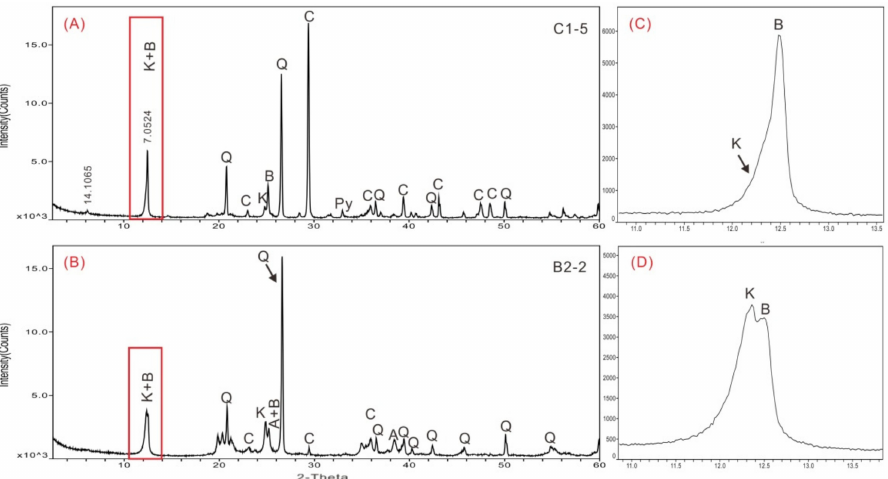
Figure 3. X-ray powder diffraction patterns of LTAs of coal samples C1-5 ( A ) and B2-2 ( B ). ( C ) and ( D ) are enlargement of the specific areas in ( A ) and ( B ), respectively. Q: quartz. B: berthierine. C: calcite. A: anatase. K: kaolinite. Py: